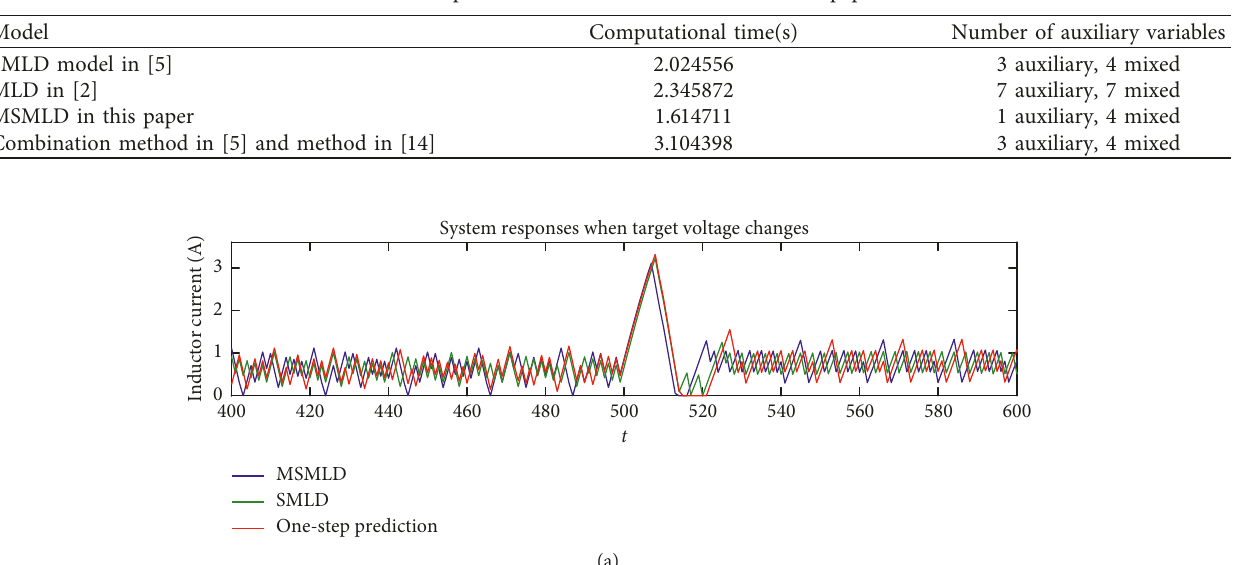
Table 3: Computational time of models mentioned in papers.